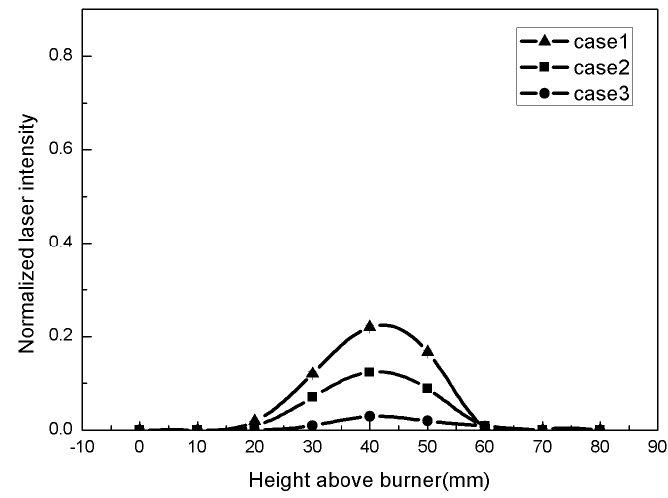
Figure 5. Axial variation of soot volume fractions at the centerline of three different flames.